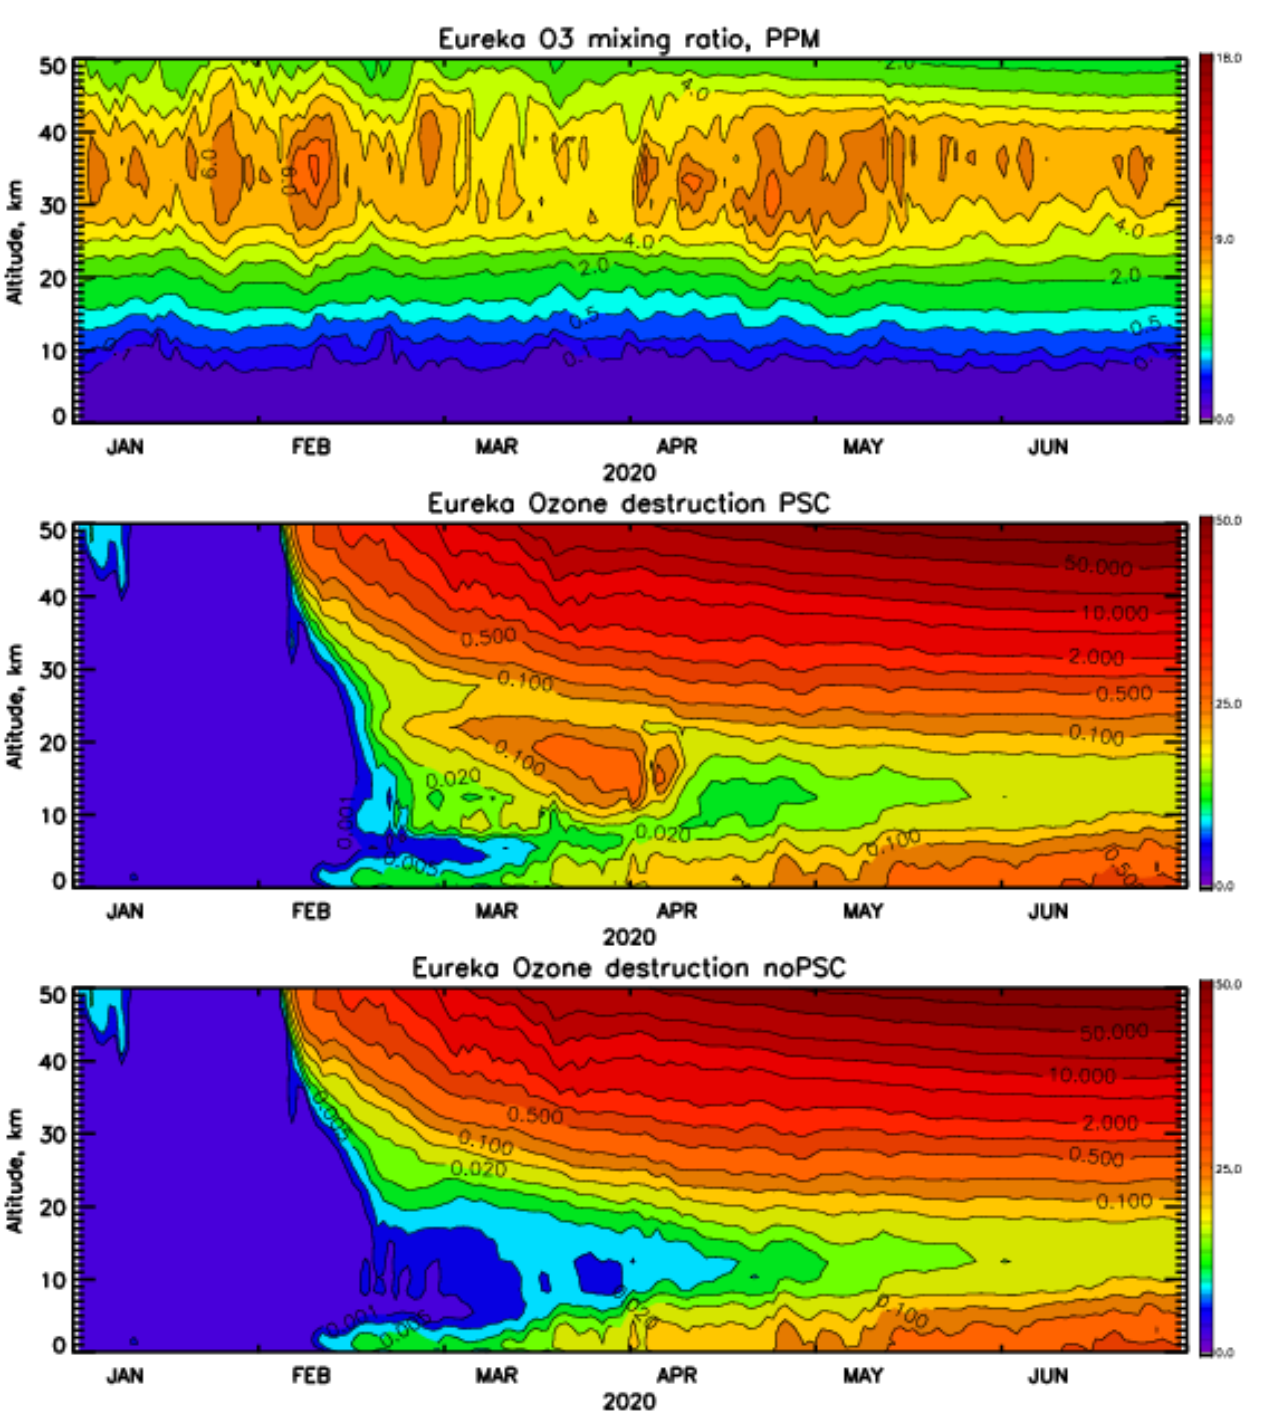
Figure 14. Ozone-mixing ratio at Eureka Station for the first half of 2020 ( top ), ozone destruction coefficient for PSC scenario ( middle ) and for noPSC scenario ( bottom ).